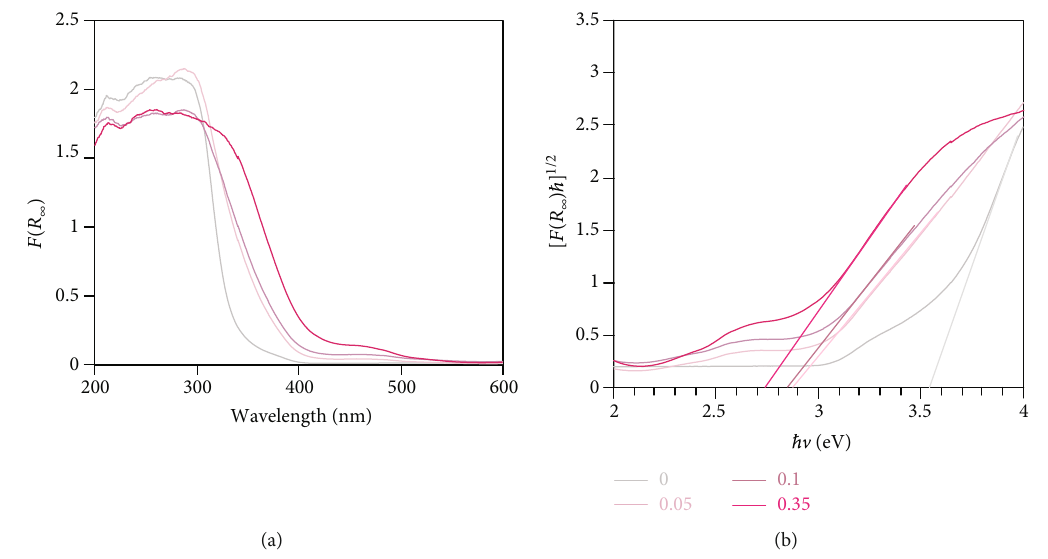
Figure 6: (a) UV-vis DR spectra and (b) Tauc plots of CTNO ( x )_600; x = 0 , 0.05, 0.1, and 0.35. Table 1: Band gap energies of di ff erent